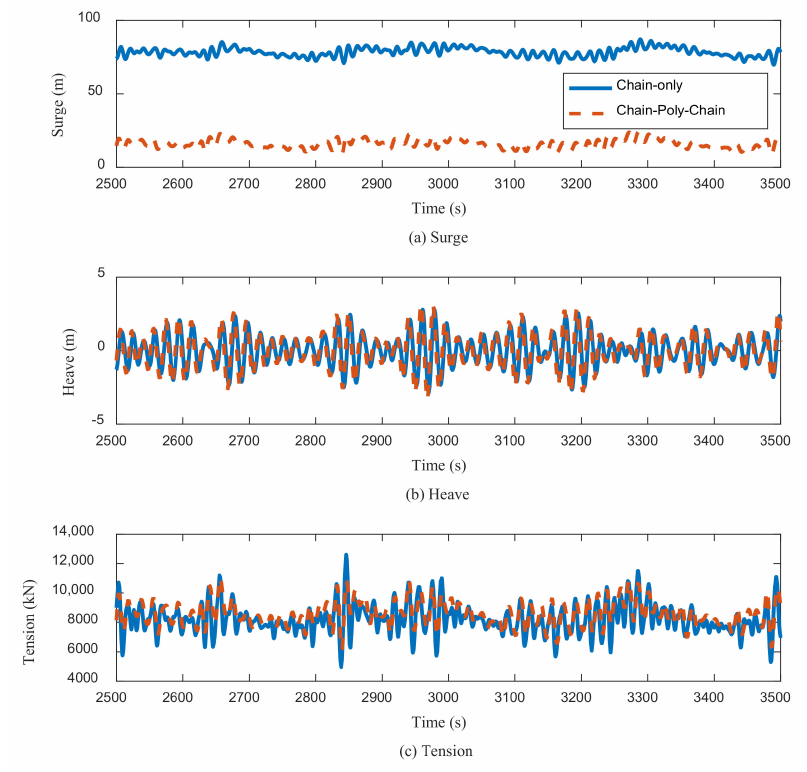
Figure 11. Time histories of FCDS motion and mooring tension with different mooring systems.